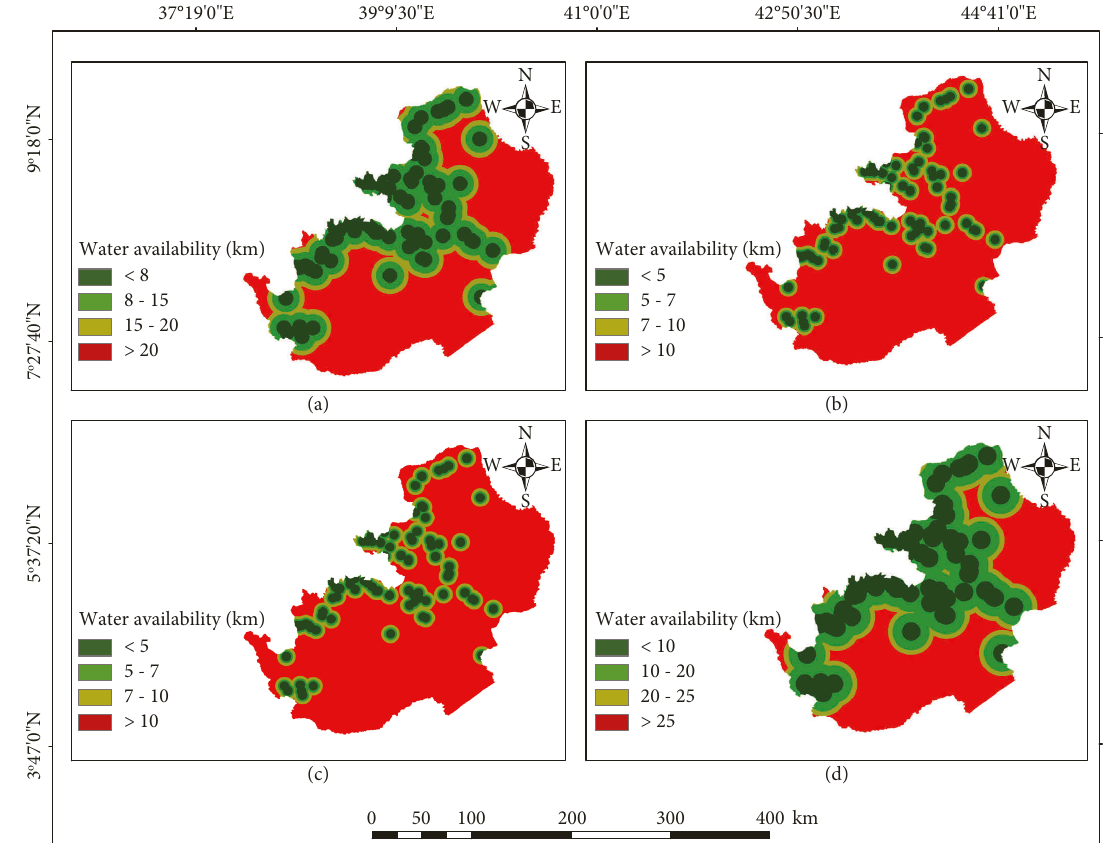
Figure 6: Water accessibility factor map for livestock production: (a) cattle, (b) sheep, (c) goat, and (d) camel.